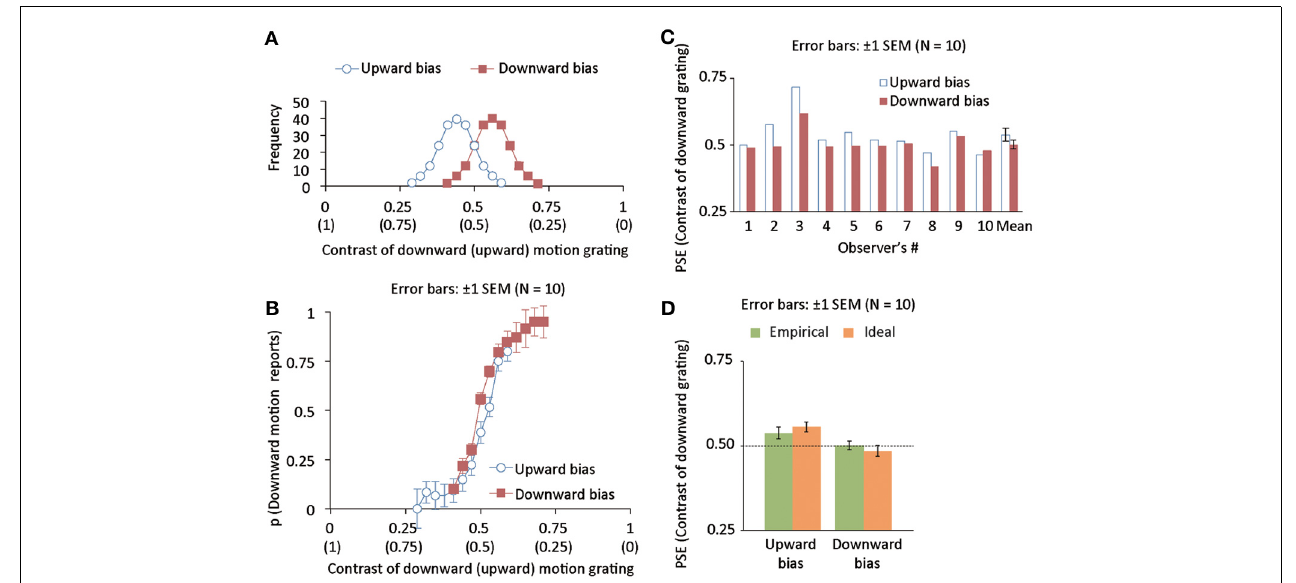
FIGURE 2 | (A) Distributions of luminance contrast for downward (and upward) drifting gratings in upward (blue, open disk maskers) and downward (red, open square markers) bias conditions. The mean of the distribution is deviated from 0.5 by 0.06 negatively and positively for upward- and downward-bias conditions. The standard deviation of the